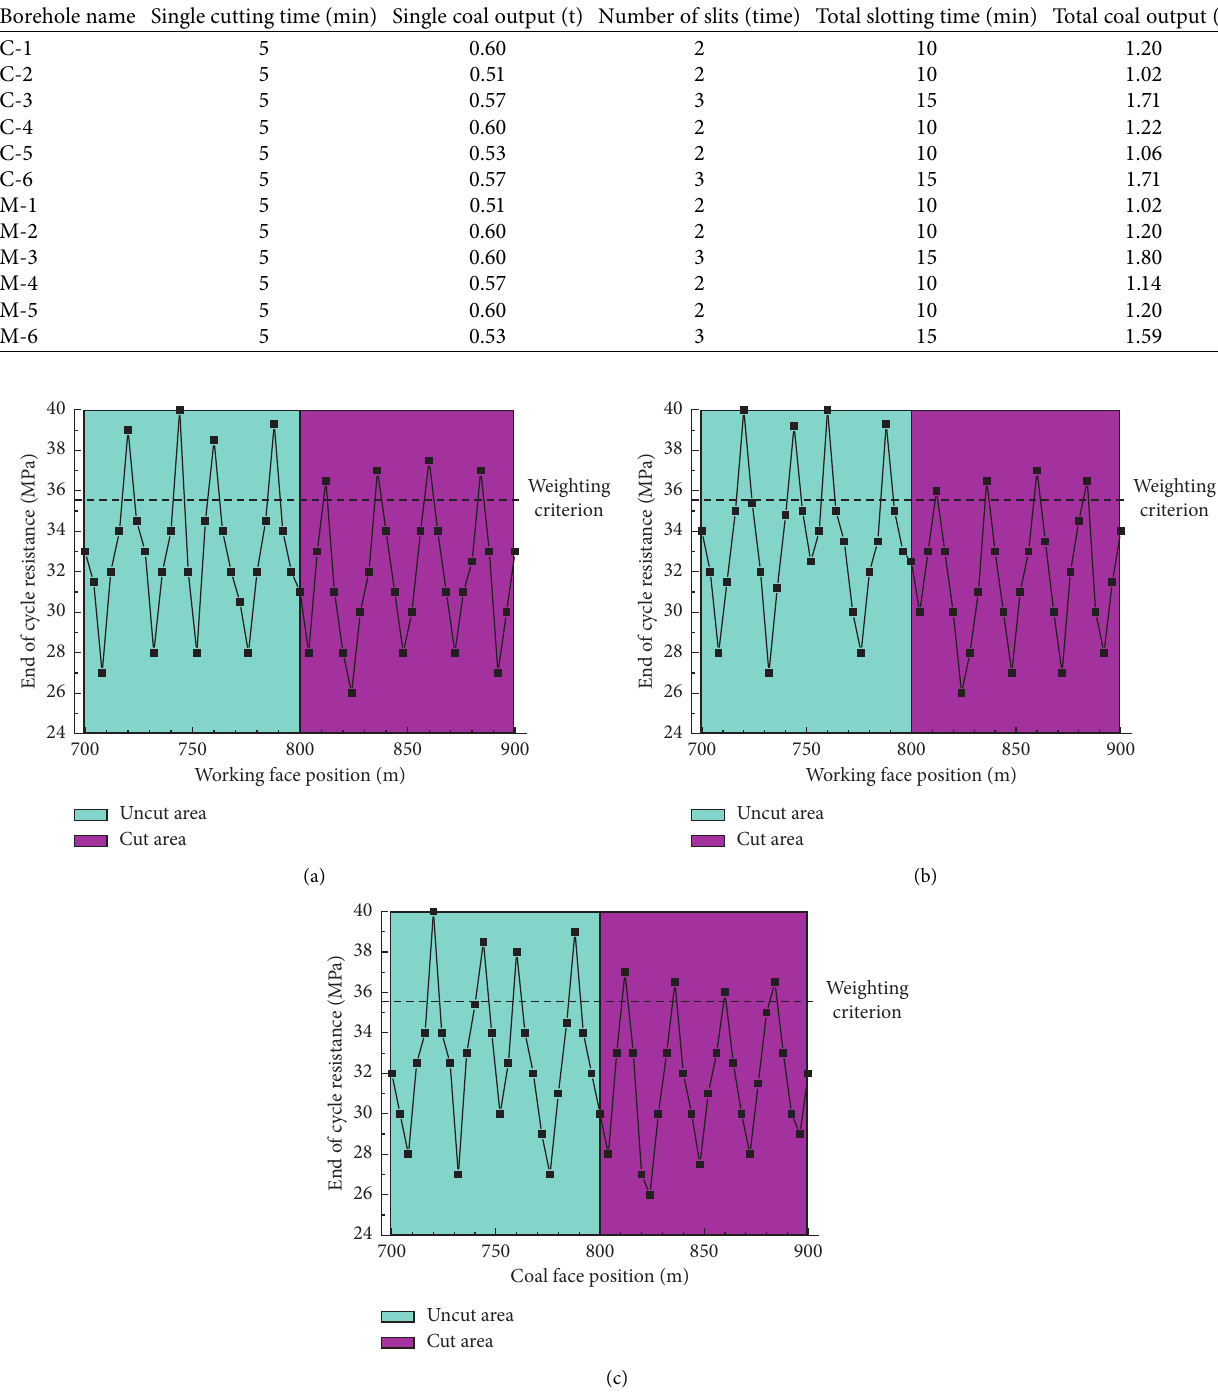
Figure 22: Data curve of typical hydraulic support under a residual coal pillar. (a) 25#. (b) 32#. (c)